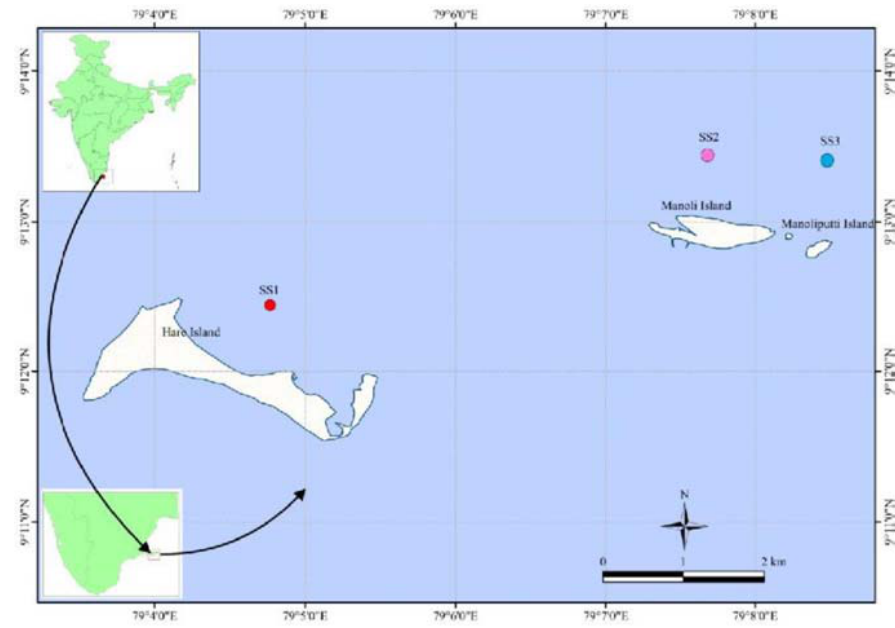
Fig. 1: The R-GIS image representation displaying the sampling universe in the Gulf of Mannar. SS1 sampling site near Hare island, SS2 sampling site near Manoli island and SS3 sampling site near Manoliputti island